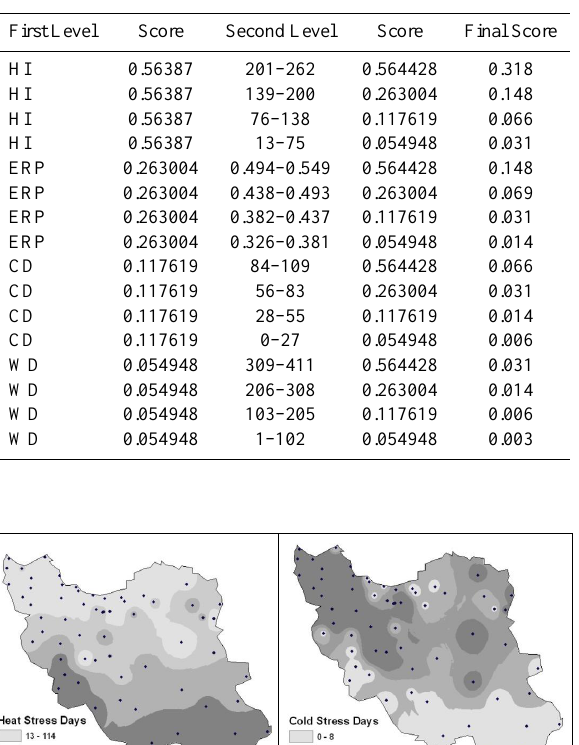
Table 4. The final scores used for classifying indices.